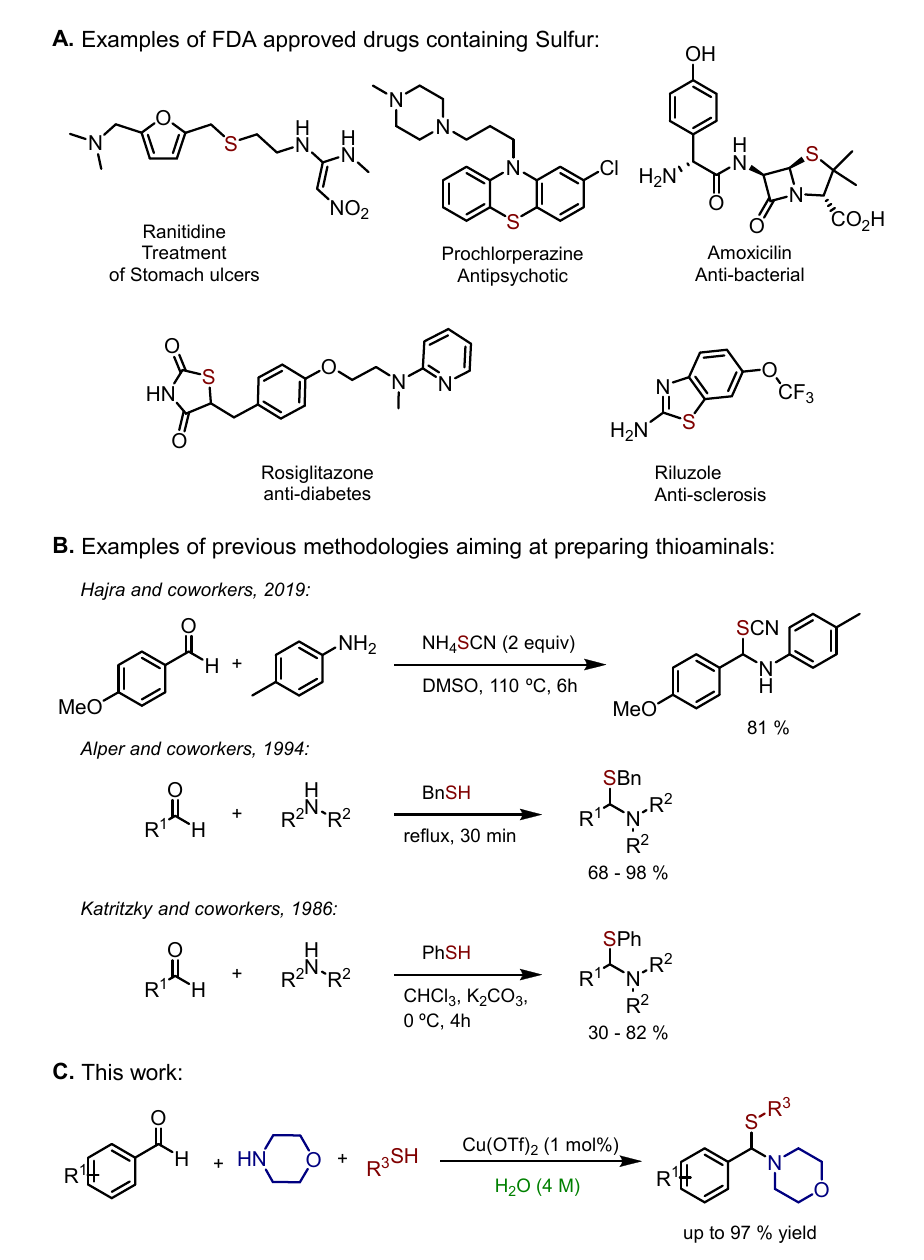
Figure 1. Importance of thiol in drug development ( A ); selected examples for the preparation